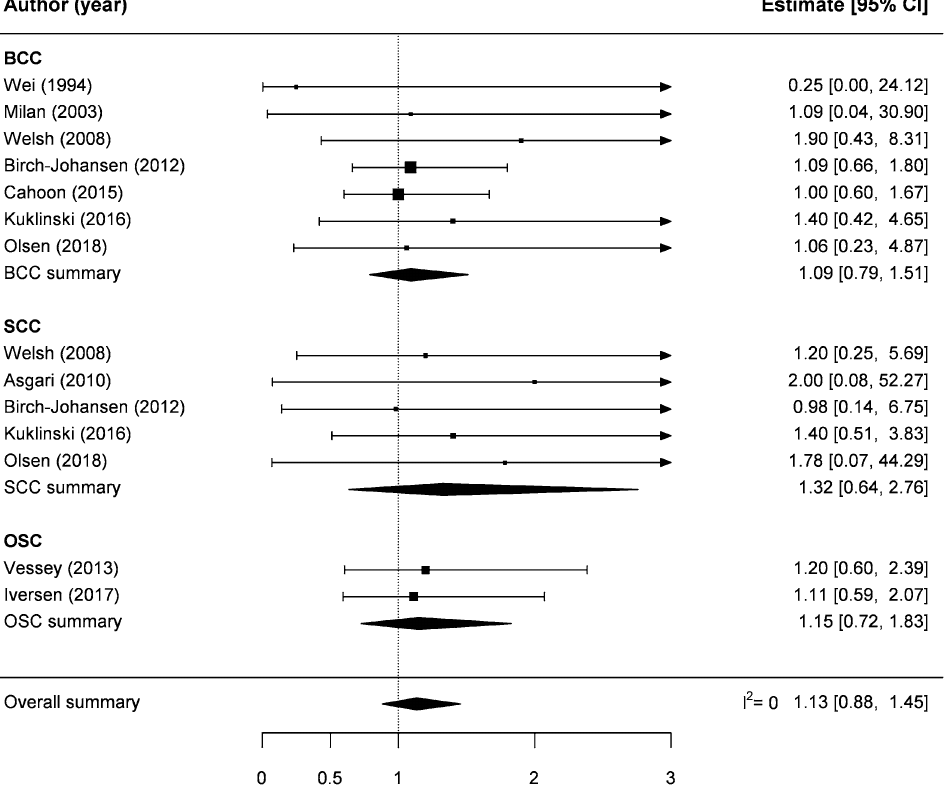
Figure 2. Forest plot for the association between use of oral contraceptives (ever vs. never) and the risk of non-melanoma skin cancer among women. BCC basal cell cancer, SCC squamous cell cancer, OSC other (not specified) non-melanoma skin